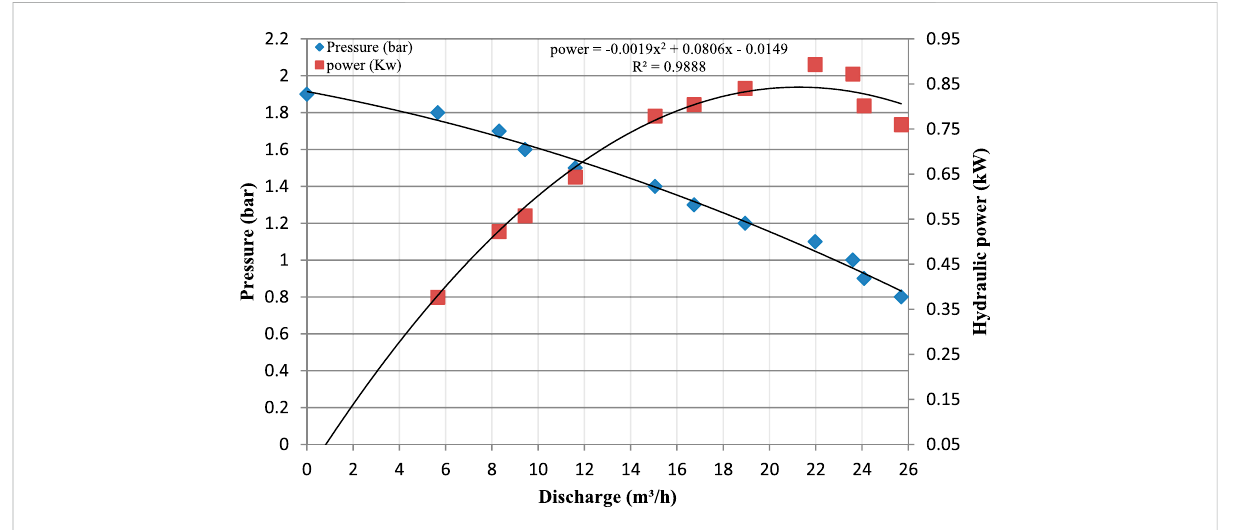
FIGURE 7 The relationship between discharge, pressure, and hydraulic power of a pump operating with gasoline at an engine speed of 3,500 rpm.